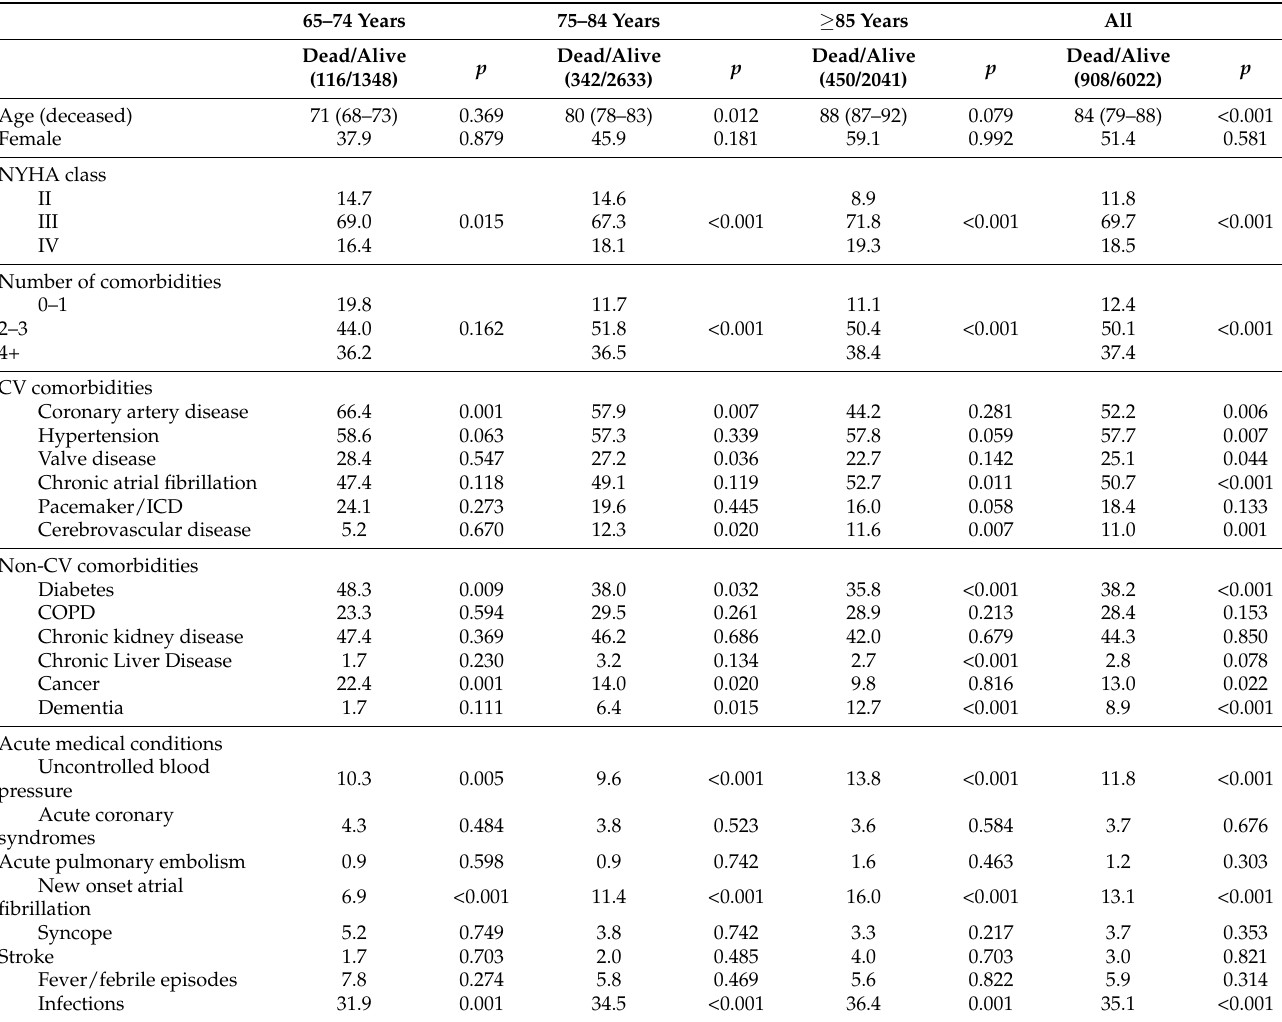
Table 4. Predictors of in-hospital mortality by age groups (Univariate analysis).